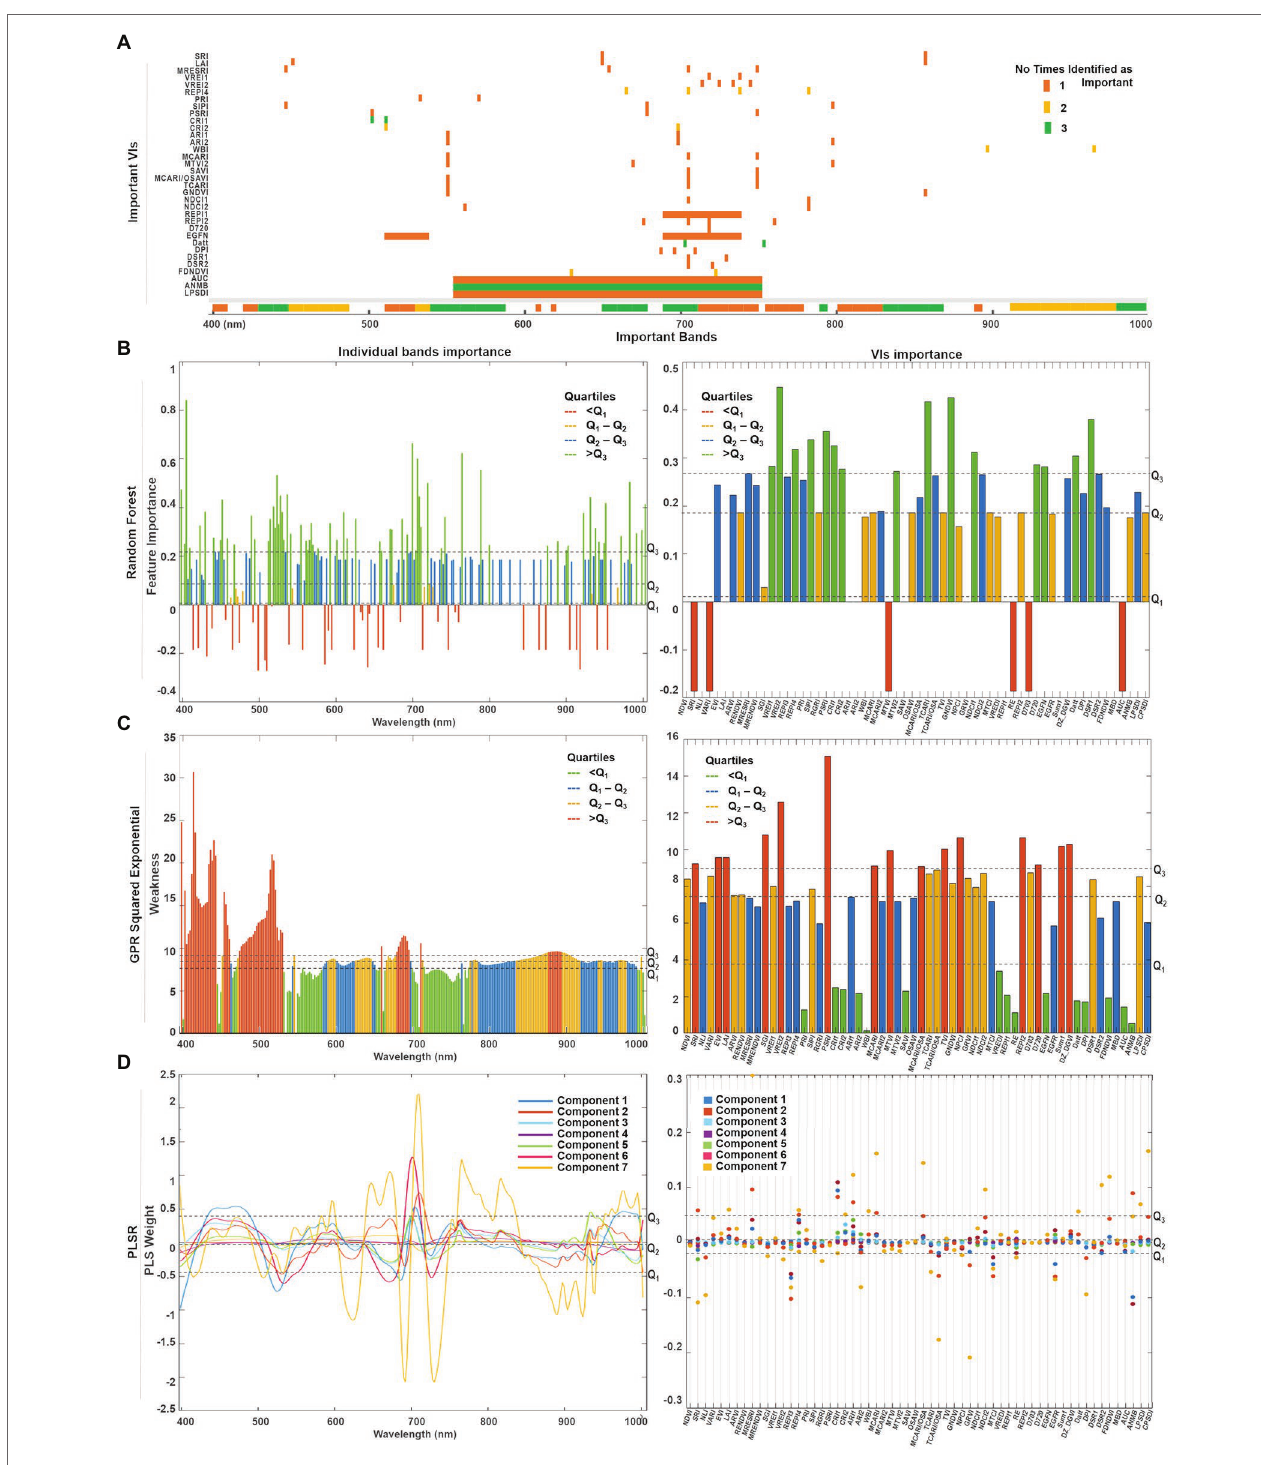
FIGURE 10 (A) Summary of the top predictors (bands and VIs) that were identified by either one (orange), two (yellow), or three (green) of the selected methods. A quartile classification was used to rank the top features of each method. (B) For random forest, the highest quartile was set as threshold to identify the most important bands ( Q 3 = 0.21) and VIs ( Q 3 = 0.27). (C) For GPR squared exponential, the lowest quartile was set as threshold to classify the less weak bands ( Q 1 = 8.02) and VIs ( Q 2 = 7.16). (D) The predictor weights were retrieved for the first seven components used to fit the PLSR model. The highest quartile was set as the threshold to denote the most relevant bands ( Q 3 = 0.48) and VIs ( Q 3 =